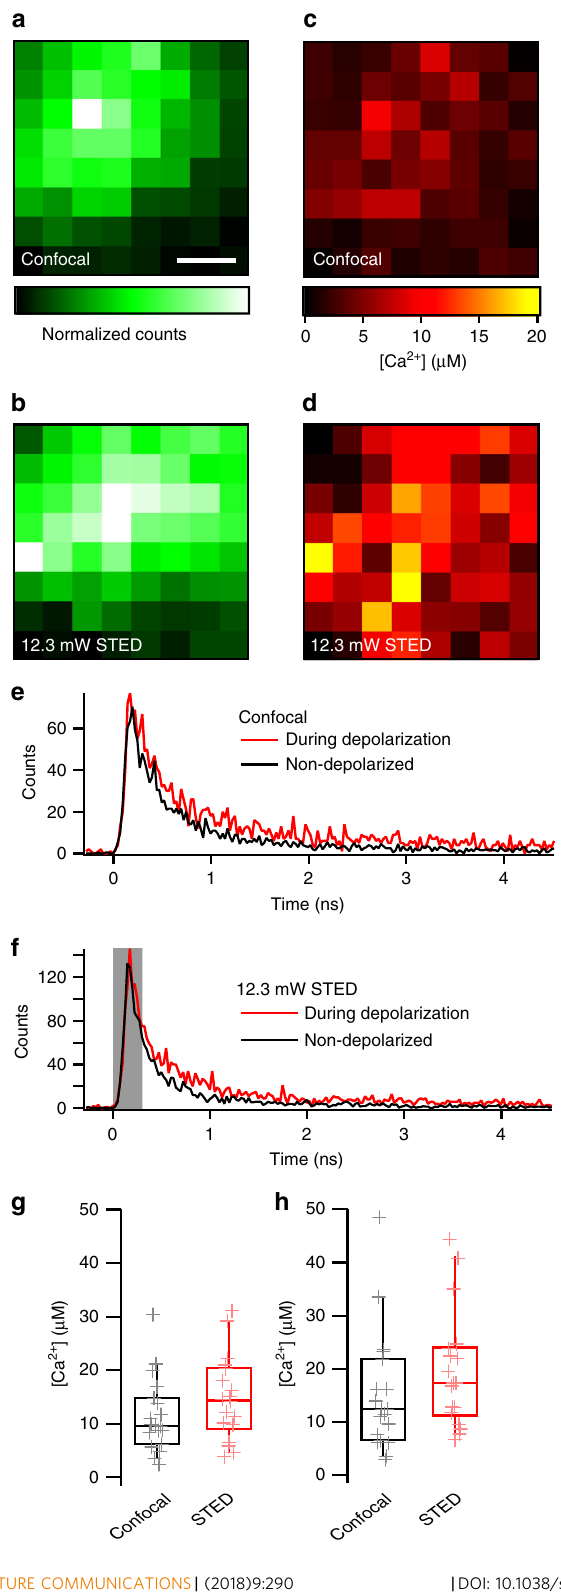
Fig. 8 Measuring synaptic Ca 2+ concentration by fl uorescence lifetime imaging. a – d Representative data from two 8 × 8 (50 nm steps in x and y ) pixel raster scans of a hotspot of Ca 2+ -in fl ux-evoked fl uorescence at the AZ, depicting the rise in fl uorescence during depolarization (left, shown for confocal imaging ( a ) and 12.3 mW STED imaging ( b )) and the corresponding Ca 2+ concentrations calculated from the lifetime data (right, c and d for confocal and STED, respectively). Scale bar: 100 nm. e , f Fluorescence lifetime traces from single pixels in the same recordings shown in a – d , acquired with confocal ( e ) and STED imaging ( f ). Red traces show the fl uorescence data during depolarization of the IHC, black traces at rest. For analysis of the STED imaging traces, we employed a blanking range (gray box). Data points inside this range were excluded from the fi tting procedure (used to establish the ratio of Ca 2+ -bound and -free dye) to avoid in fl uence of the arti fi cial STED-evoked short lifetime component. g Average maximum Ca 2+ concentrations (black symbols) calculated as “ scaled lifetime ratios ” from the fl uorescence lifetime data of recordings acquired using both confocal imaging (left, n = 19 AZs, N = 19 IHCs) and STED imaging (right, n = 18 AZs, N = 18 IHCs) show an increase in measured Ca 2+ concentration using STED imaging. h Same as in g